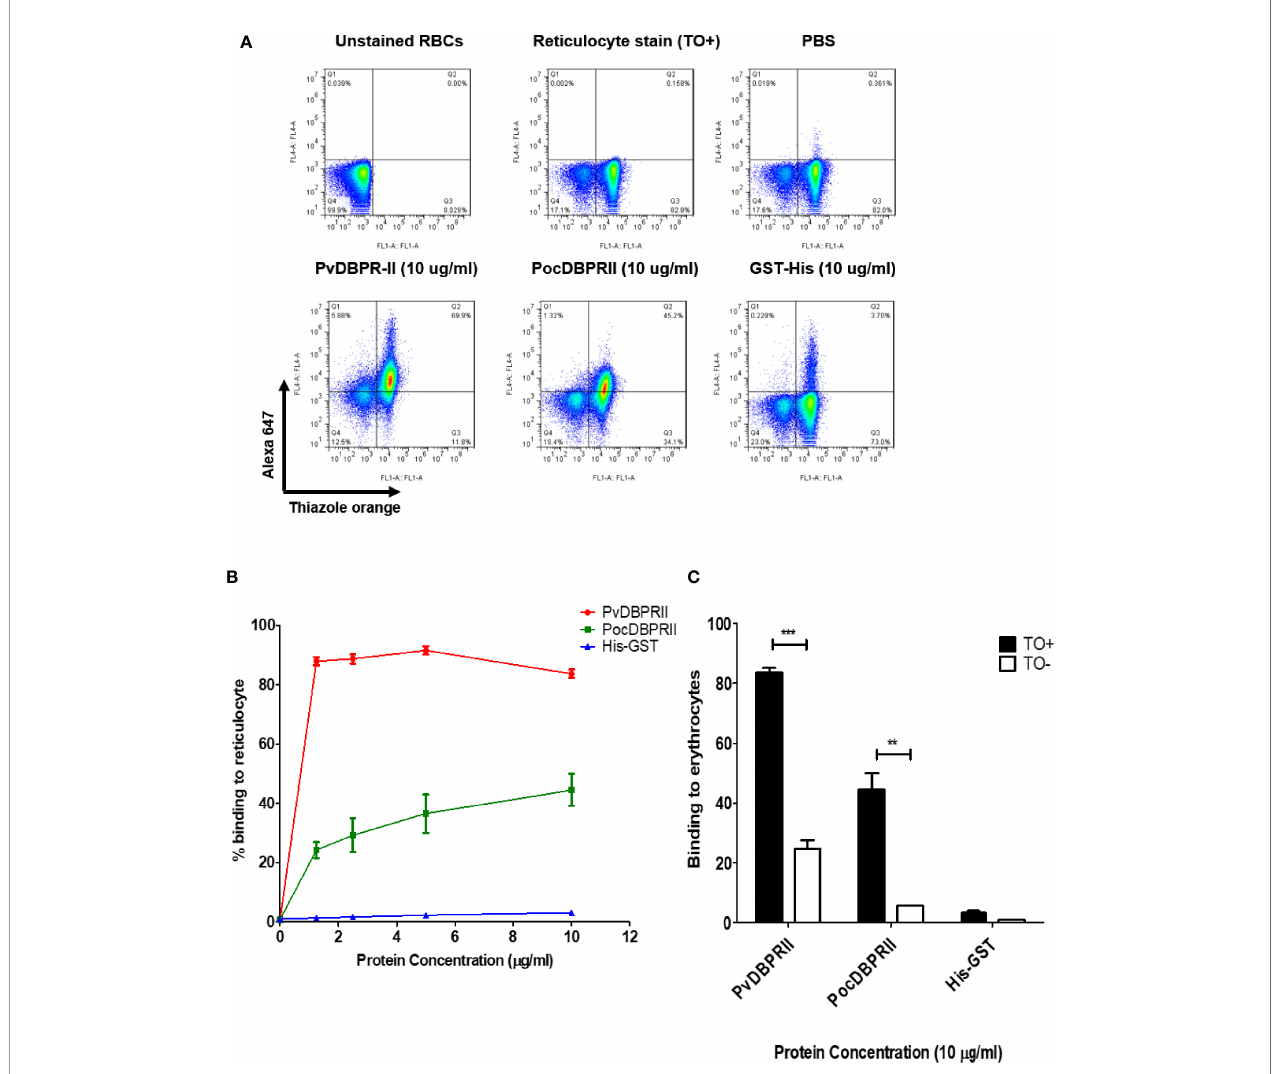
FIGURE 4 | Reticulocyte-binding activity of recombinant PocDBP-RII in the FACS-based assay. (A) Dot plot patterns. Unstained RBCs, gating control (upper left); enriched reticulocytes, thiazole orange, TO+ (upper center); binding control without protein, phosphate-buffered saline (PBS) in the added fractions (upper right). Recombinant proteins (10 m g/ml) added to the test samples are shown in the lower image. (B) Reticulocyte-binding assay showing the total binding percentage of reticulocytes with gradient concentrations of the proteins. The PvDBP-RII and GST-His proteins were used as positive and negative controls, respectively. The data are shown as the mean ± standard deviation (SD) of at least three independent experiments. (C) The bar chart shows the binding of the PvDBP-RII, PocDBPRII and GST-His proteins (each at 10 m g/ml) to TO (+) (normocytes) and TO (-) (reticulocytes). Signi fi cant differences are shown as double asterisks, p < 0.002; triple asterisks <0.0001. The data are shown as the mean ± SD of at least three independent